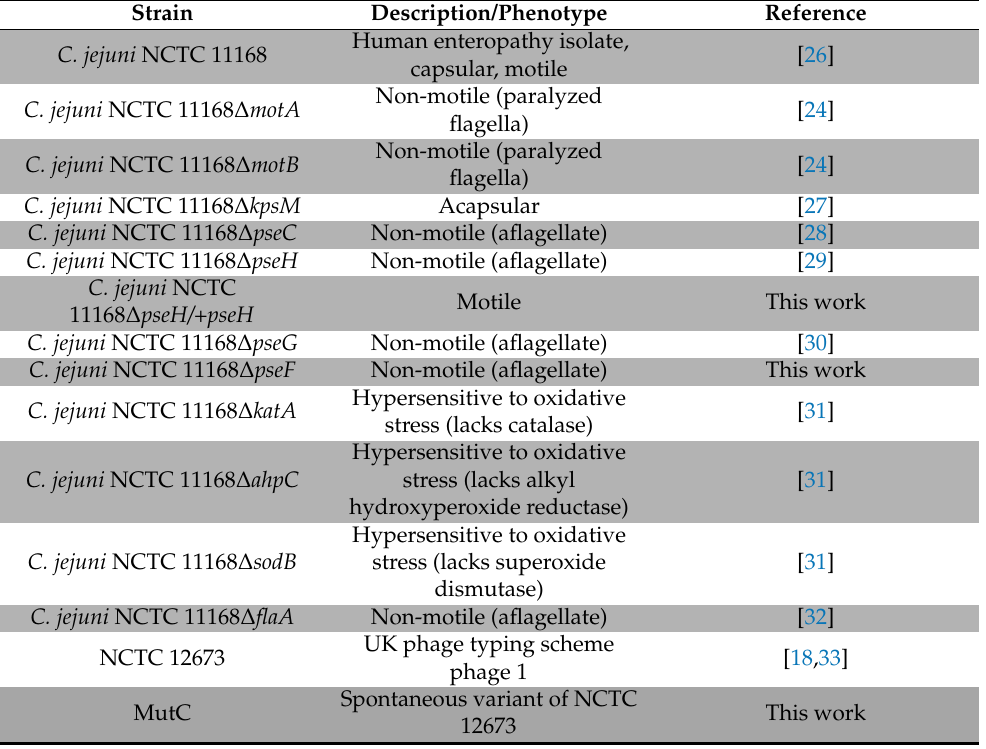
Table 1. List of strains and phages used in this